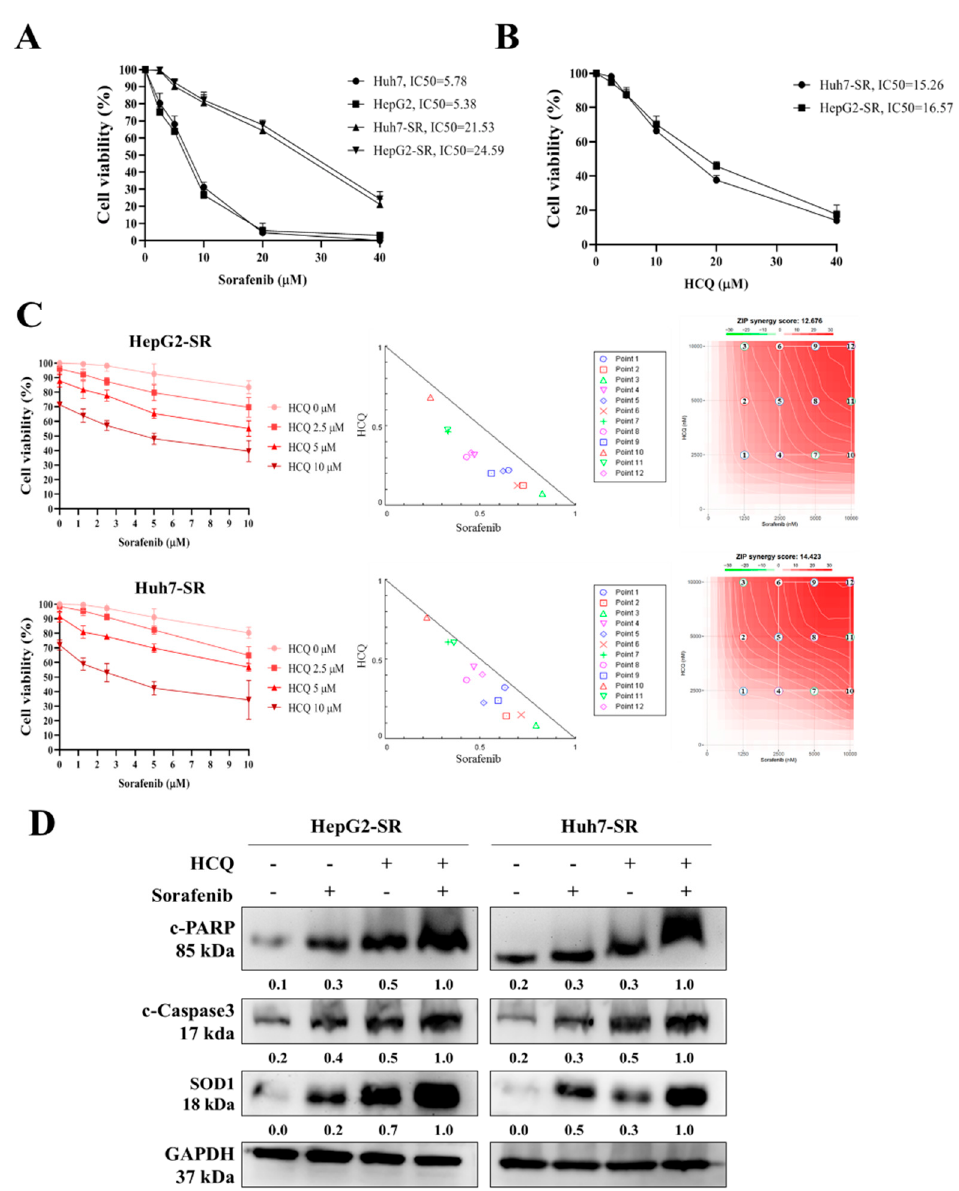
1 (Figure 8D). The effect of hsa-miR-30a-5p on sorafenib-resistant HCC (Huh7-SR) cells was evaluated using gain-and-loss-of-function experiments (Figure 8E,F). hsa-miR-30a-5p overexpression significantly inhibited ATG5 and Beclin-1 expression after transfection with hsa-miR-30a-5p (mimic) in comparisons with the control group, whereas hsa-miR-30a-5p inhibition cells significantly elevated ATG5 and Beclin-1 mRNA and protein expression. Notably, TLR9 expression and SOD1 level were also modulated due to hsa-miR-30a-5p inhibition/overexpression.